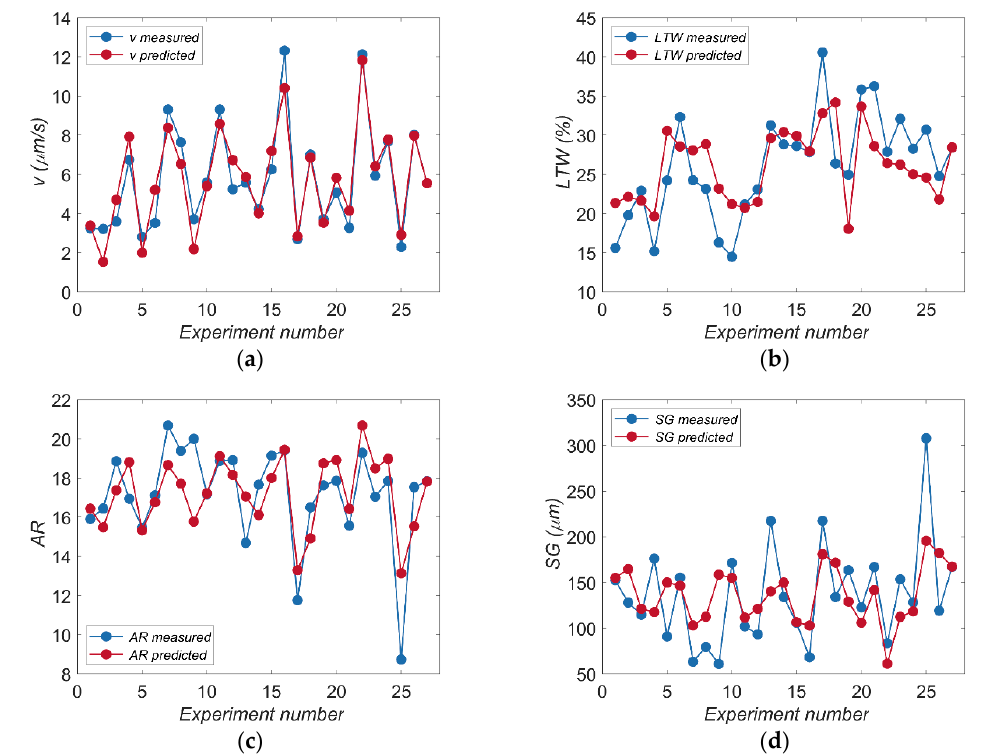
Figure 6. Comparison of measured and predicted values for: ( a ) drilling speed— v ; ( b ) the linear tool wear— LTW ; ( c ) the aspect ratio hole— AR ; ( d ) the side gap thickness— SG .